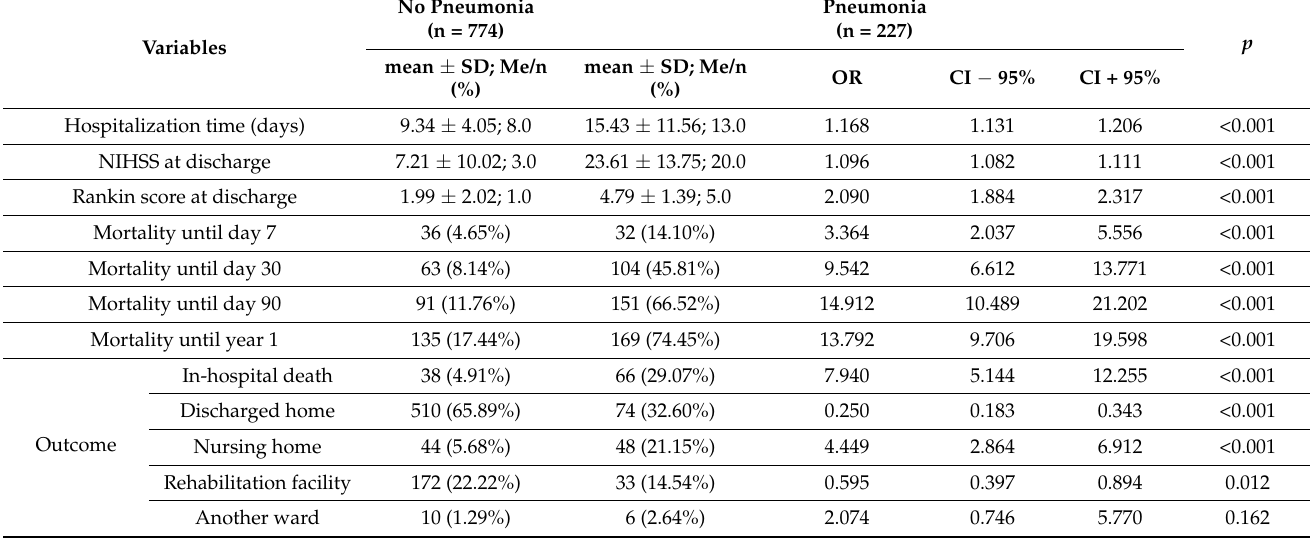
Table 3. Outcome data for the admitted ischemic stroke patients.